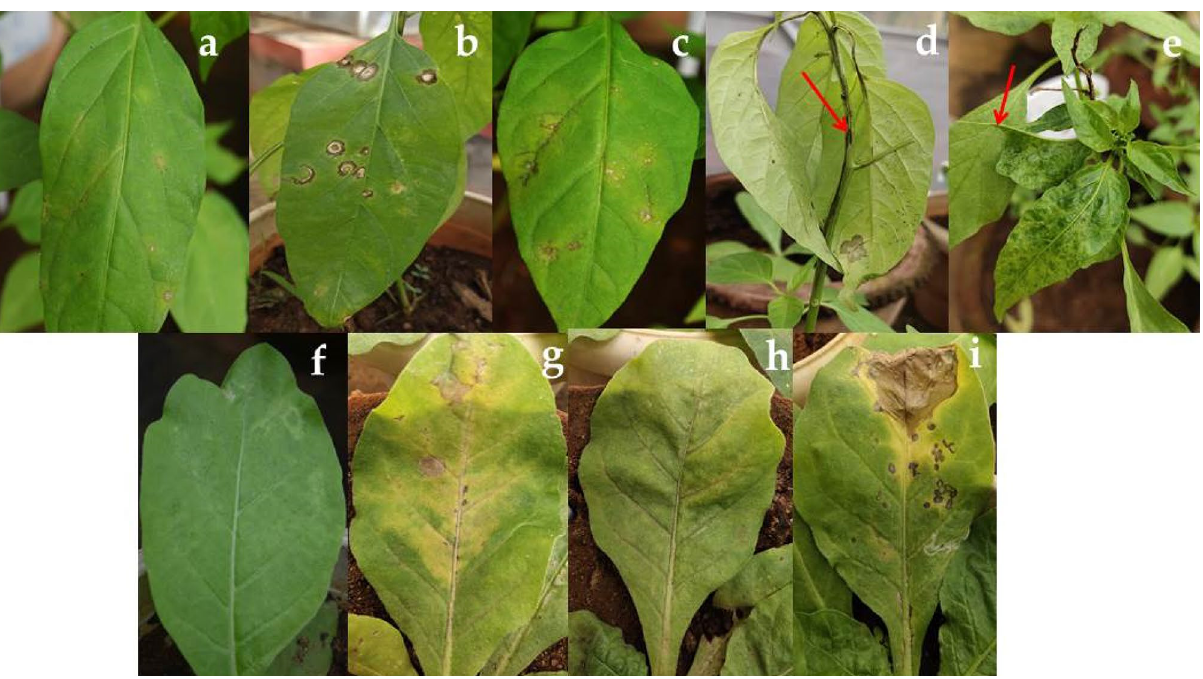
Figure 3. Symptomatological studies on sap inoculated chilli and Nicotinana plants for mixed infection: ( a ) chilli plant showing chlorotic lesions at 2 dpi (mixed infection of CMV with CaCV); ( b ) chilli plant showing necrotic lesions at 3–4 dpi (mixed infection of CMV with CaCV); ( c ) veinal necrosis on chilli at 5 dpi (mixed infection of CMV with GBNV); ( d ) stem necrosis on chilli at 7 dpi (mixed infection of CMV with GBNV); ( e ) chilli plant showing leaf filiformitity and mosaic mottling at 10–12 dpi (mixed infection of CMV with CaCV); ( f ) chlorotic lesions on Nicotiana at 2–3 dpi; ( g ) mosaic and necrotic lesions on Nicotiana at 7–8 dpi (mixed infection of CMV with CaCV); ( h , i ) mosaic and Necrotic lesions on Nicotiana at 7 dpi (mixed infection of CMV with GBNV)